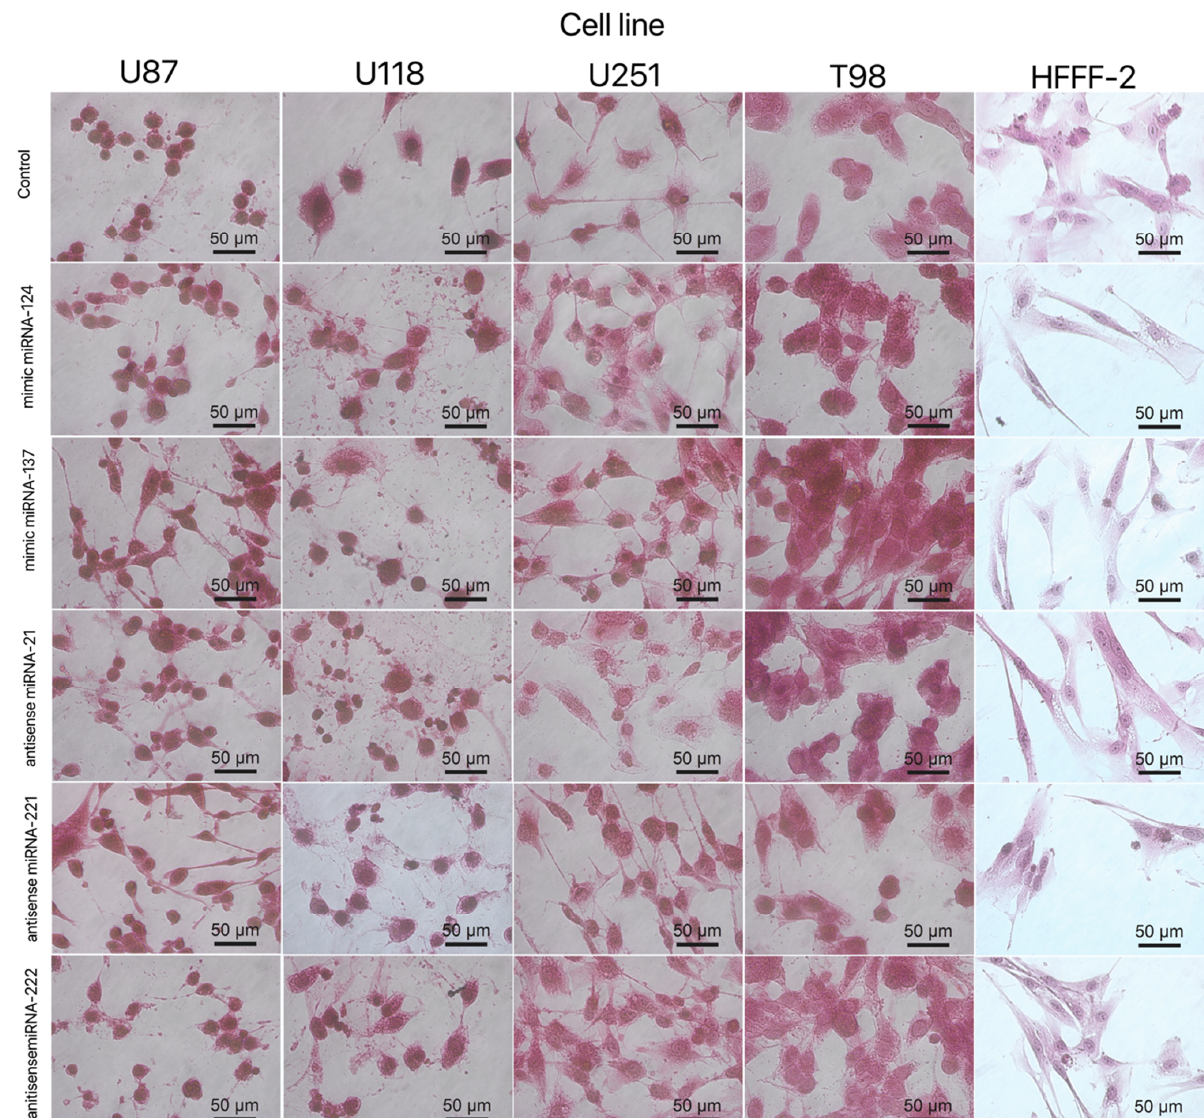
Figure 11. Morphology of U87, U118, U251 and T98 glioblastoma and HFFF-2 cells treated with mimic miRNA-124, mimic miRNA-137, antisense miRNA-21, antisense miRNA-221 and antisense miRNA-222. Scale bars: 50 µm. The mimic miRNA-124 and -137 transfections of GBM cells had the smallest impact on the reduction in disorganised arrangement in cell culture (Figure 11). The antisense miRNA-21 at all investigated cell lines reduced cell density, the number of cell tentacles and the size of the cell body. Zhang et al. [40] also indicated that the downregulated level of miRNA-21 may reduce the malignancy and invasiveness of GBM. Moreover, 24 h post transfection, the morphology of GBM cells did not present characteristic features of cancer cells, including large variability and sharpened nuclei, many dividing cells or variation in the size and shape of the cell body. The antisense miRNA-221 and -222 caused a similar cell aberration in the cellular structure to the antisense miRNA activity against the GBM cell lines. To confirm the essential role of the selected sequence of miRNA on the activation of the signalling pathway involved in apoptosis and proliferation, the p21, p53, Bcl-2, Bcl- 2-associated X protein (BAX) and proliferating cell nuclear antigen (PCNA) gene expres- sion level were investigated (Figure 12). Transfection by electroporation did not cause sig- nificant changes at the gene expression level in the U87 GBM cell line. The proapoptotic